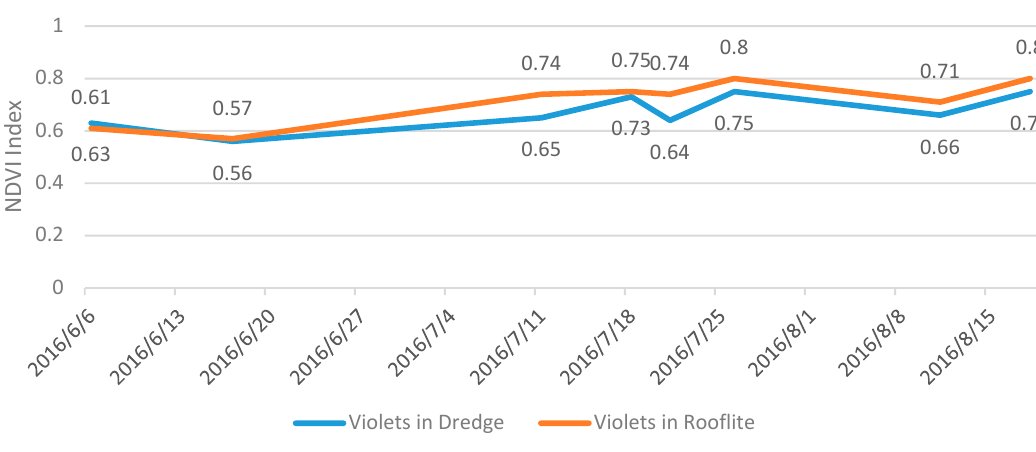
Figure 8. NDVI comparison graph, Violets in Dredge vs. Violets in Rooflite ® . Table 4. Plant Coverage Area value.